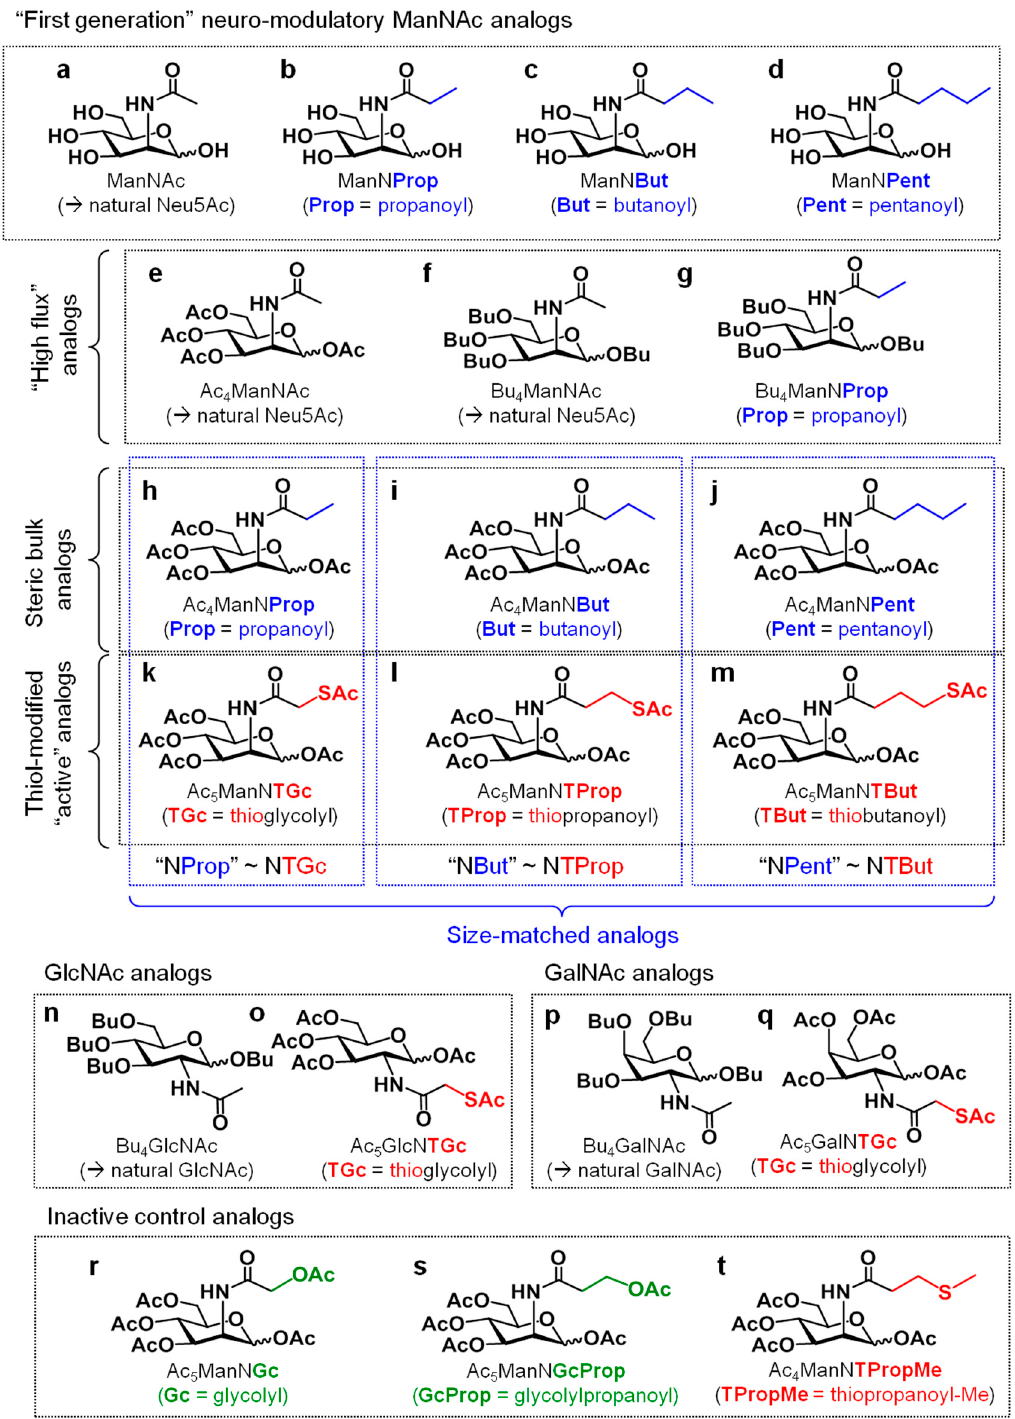
Figure 2. Thiol-modified (and control) analogs ( a – t ). Chemical structures of hexosamine analogs mentioned in this report (note that not all analogs shown were used in all experiments and the names used here conform to those used in previous publications, e.g., Prop, But, and Pent refer to the propanoyl-, butanoyl-, and pentanoyl-modified hexosamines [1,22,23] and ‘TGc’ denotes thio-analog counterparts to the glycolyl sugars [5,20] ).